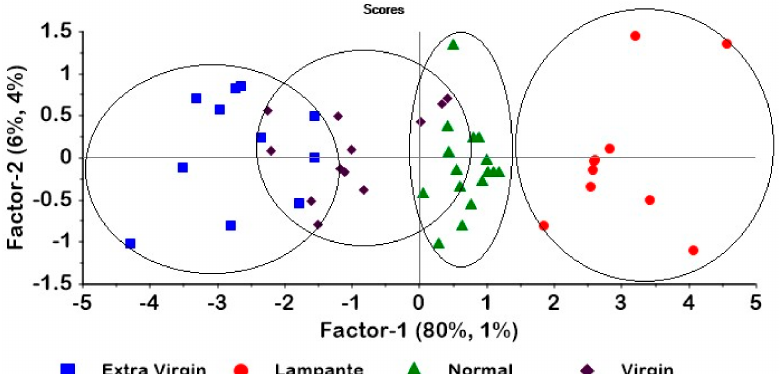
Figure 5. Scores plot of the partial least squares-1 (PLS-1) model between electronic nose (EN) (X- matrix) and acidity (Y-matrix) for all 50 samples of olive oil using full cross-validation. Two principal components (PCs) explained 86% and 5% of the variance of EN signals and acidity values,